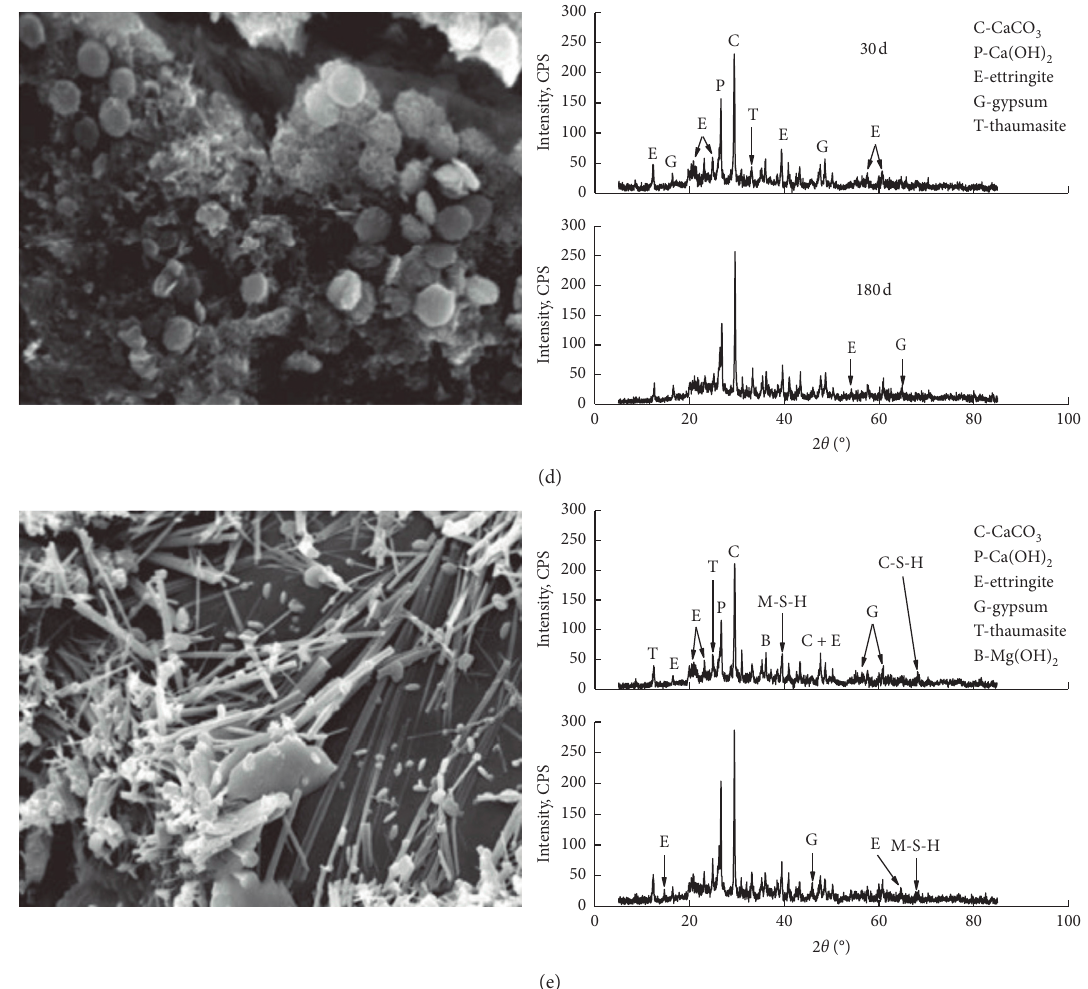
Figure 7: SEM images (180d) and XRD patterns of CGBM immersed in different solutions. (a) Uneroded, (b) 5% Na Na 2 SO 4 +5% MgSO 4 composite solution, (d) 5% Na 2 SO 4 +5% NaHCO 3 composite solution, and (e) 5% Na 2 SO 4 +5% MgSO 4 +5% NaHCO 3 composite